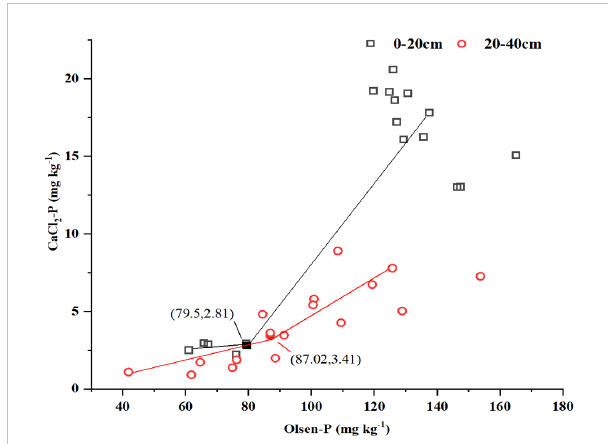
FIGURE 8 Relationships between CaCl 2 -P concentration and available-P (Olsen-P) at two soil layers for 3 treatments in the current study. The coordinates for the signi fi cant change points are indicated in parentheses; the fi rst number indicates the X value, and the second number indicates the Y value.